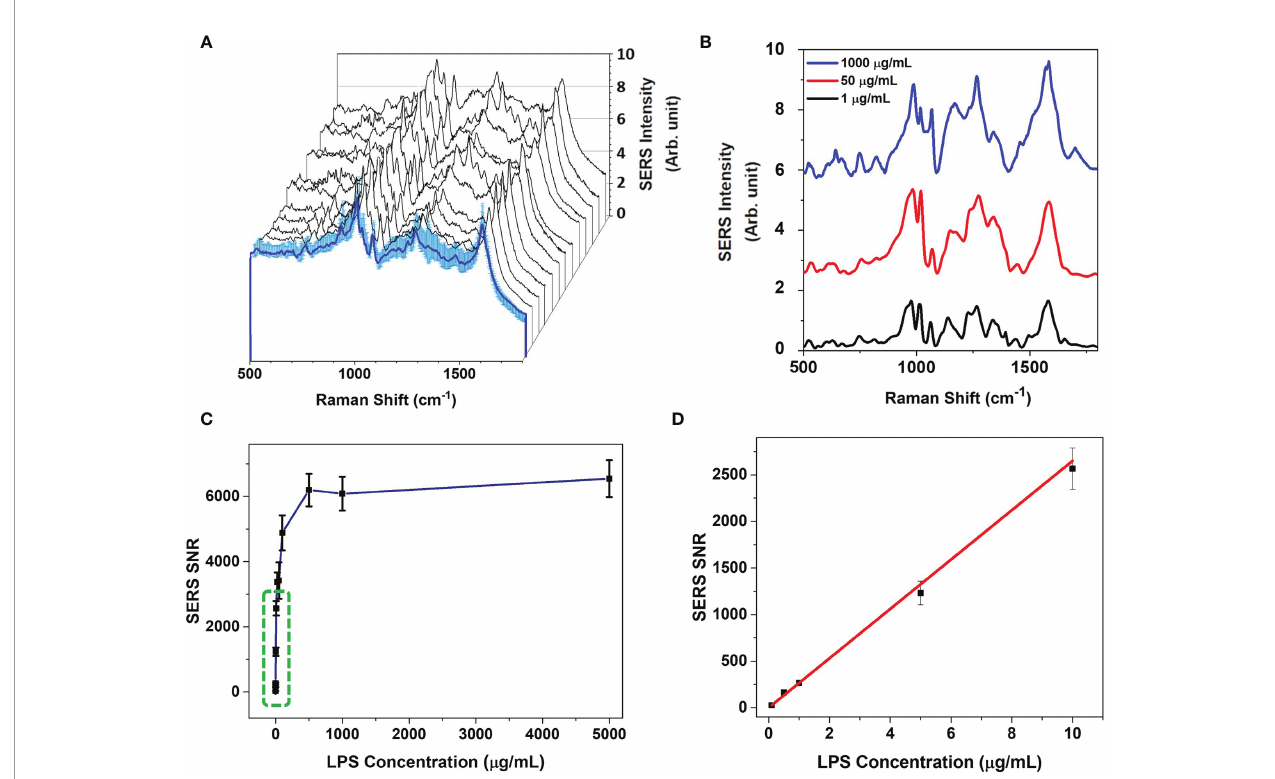
FIGURE 6 | SERS measurements of the LPS-AuNPs. (A) Variability of raw SERS signals acquired on AuNP clusters related to a single concentration of LPS (1 mg/mL). (B) Average background-corrected SERS signals of AuNPs incubated with different LPS concentrations. LPS concentration ( m g/mL) associated to each average SERS spectra are indicated on the right. Every SERS signal is obtained by averaging 30 spectra. (C) 1610 cm -1 peak SERS intensity signal to noise ratio (SNR) as a function of LPS concentration. The blue line represents the theoretical trend for concentration-dependent SERS signals. Green dashed square highlights the linear region of the trend, reported in the panel (D) . (D) Linear region of SNR on which LOD was estimated. Means ± SD of 1610 cm -1 peak SNR are reported. The red line represents the linear fi t of the experimental